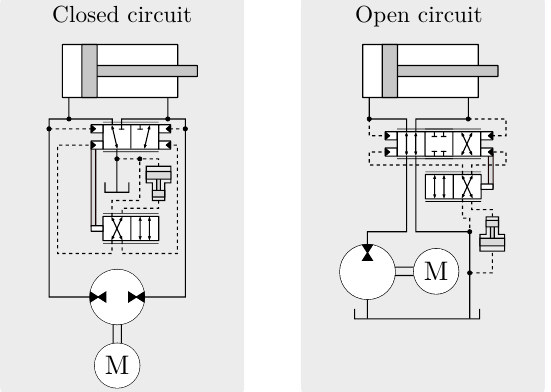
Figure 7. Examples of how hydro-mechanical hysteresis can be implemented. The circuits have not been investigated in detail.